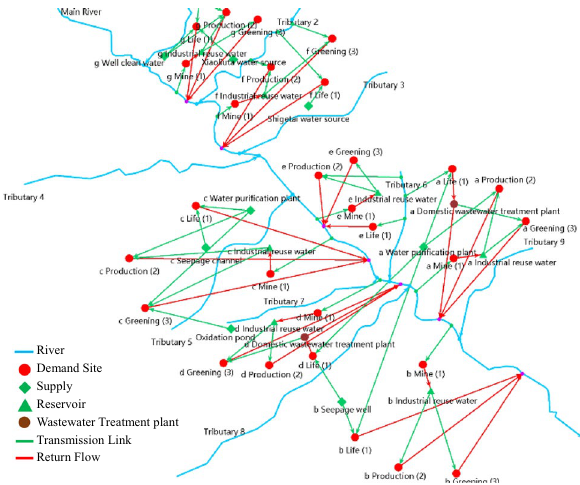
Fig. 2 Generalized figure of WEAP water resources model in studied mining